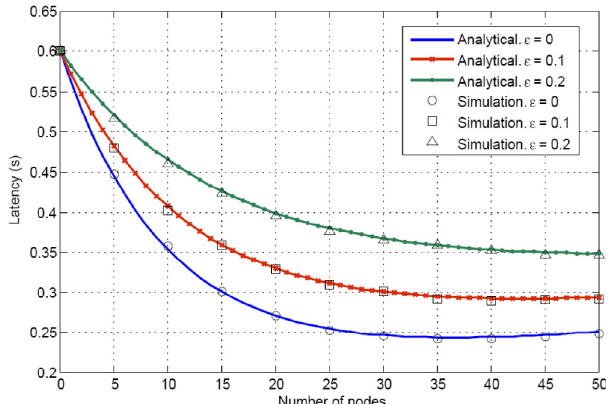
Figure 8. Latency of the IPAA protocol as a function of network size with message loss rate as a parameter.